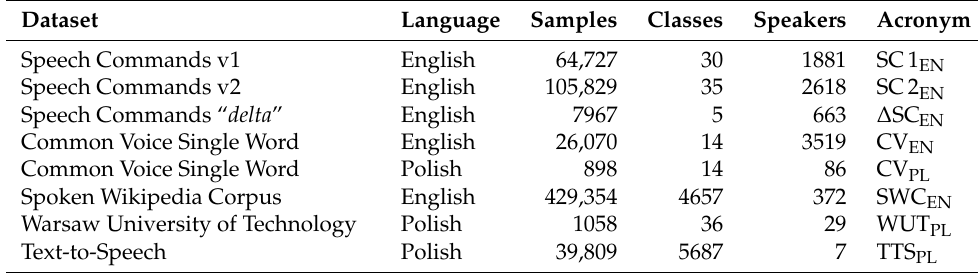
Table 2. Statistics of the training